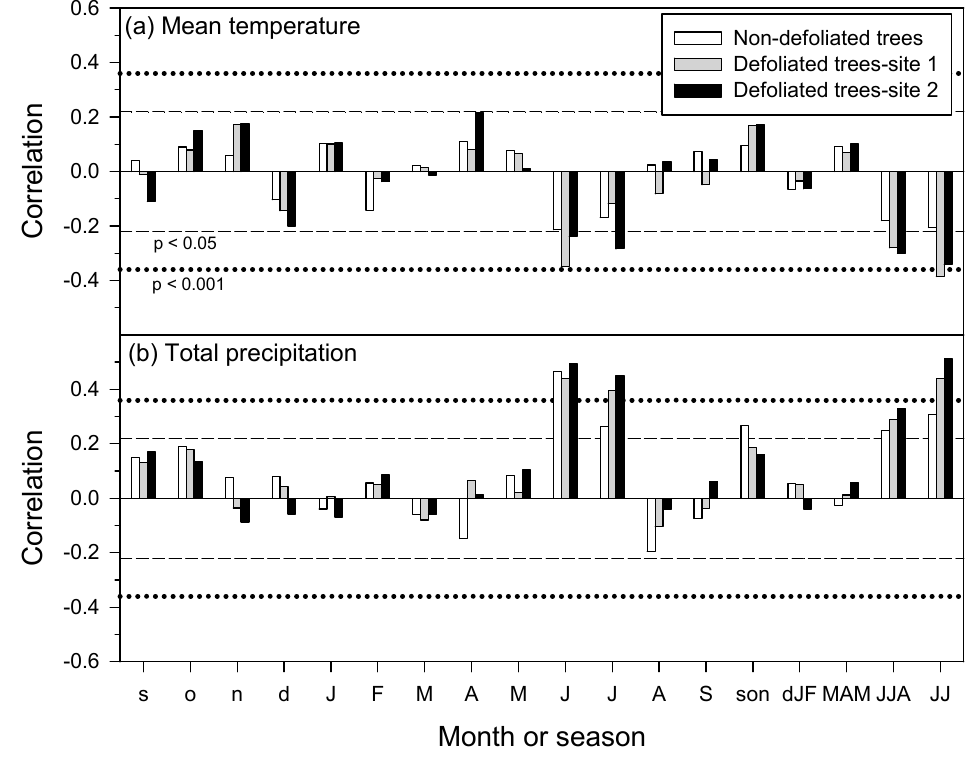
Figure 5. Climate–growth relationships based on Pearson correlations calculated between mean series of ring-width indices of the three spruce stands and monthly or seasonal climate data (mean temperature, total precipitation). The window of analyses included from the prior to current September with months of the previous year abbreviated by lowercase letters. The last bars correspond to June–July (JJ). The dashed and dotted horizontal lines show the 0.05 and 0.01 significance levels, respectively. Correlations were calculated for the period 1950–2016.